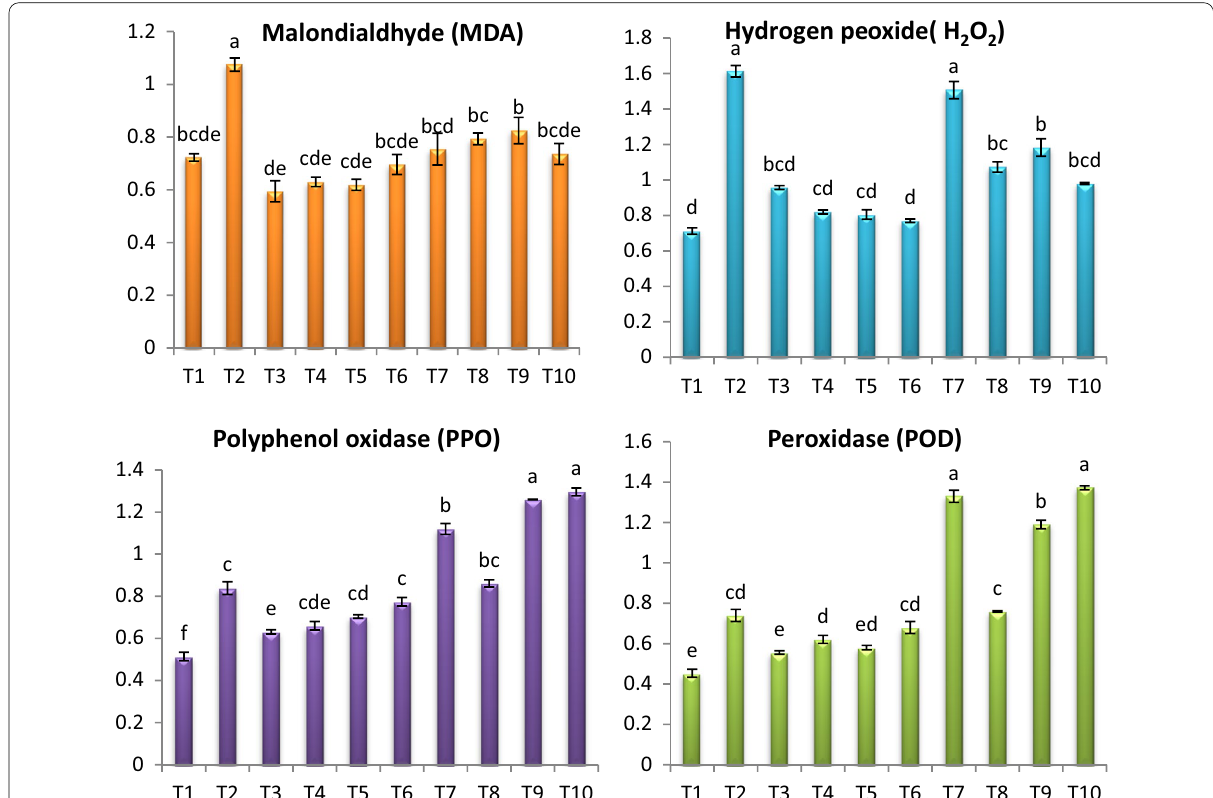
SD (n 3). Data followed by different letters are significantly different LSD test at ± =